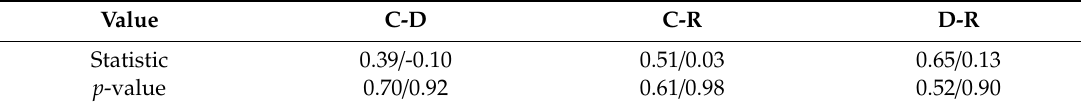
Table 7. Vuong test for C-, D-, and R-vine. The data before “ / ” represent Vuong test values in the period of B-IRSN, and the data after “ / ’ represent Vuong test values in the period of